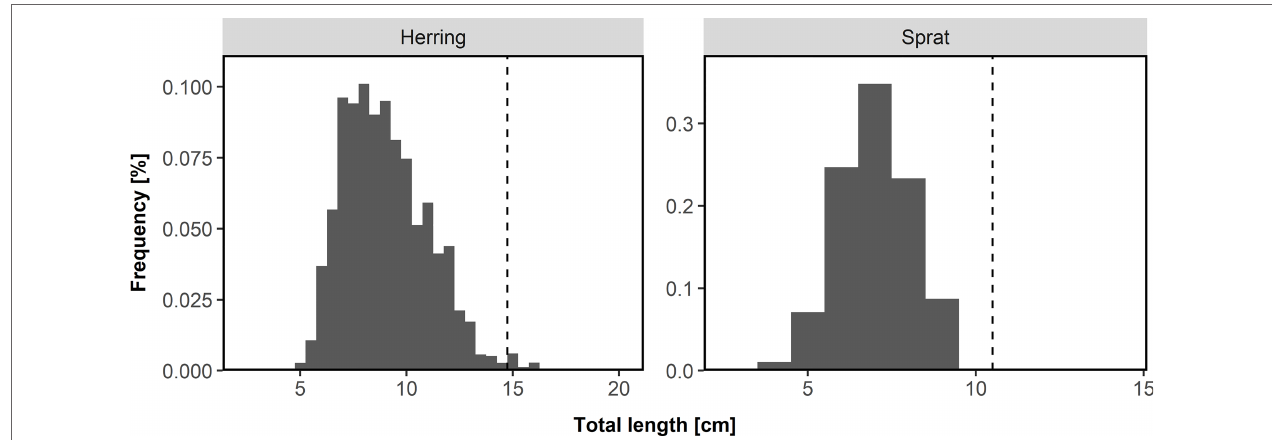
FIGURE 2 | Length distribution of herring and sprat collected from 1919-2018 during the annual beach seine survey along the Norwegian Skagerrak coast by region. Dashed line indicates separation between 0-group and age 1